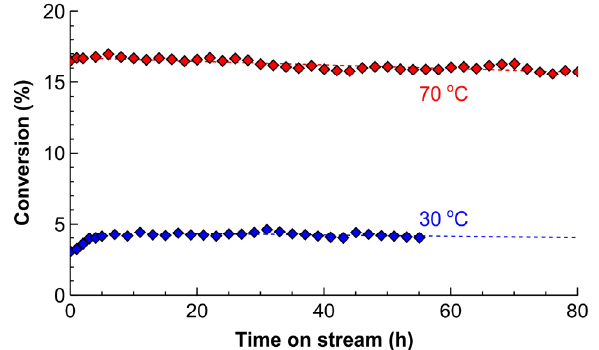
Figure 8. Deactivation of the 5 wt% Pd/ZnO catalyst coated inside a 0.86 m tube reactor at 30 °C and 70 °C. Reaction conditions: 100 μ L min − 1 solvent ‐ free MBY and 10 mL min − 1 (standard temperature and pressure, STP) H 2 at ambient pressure.